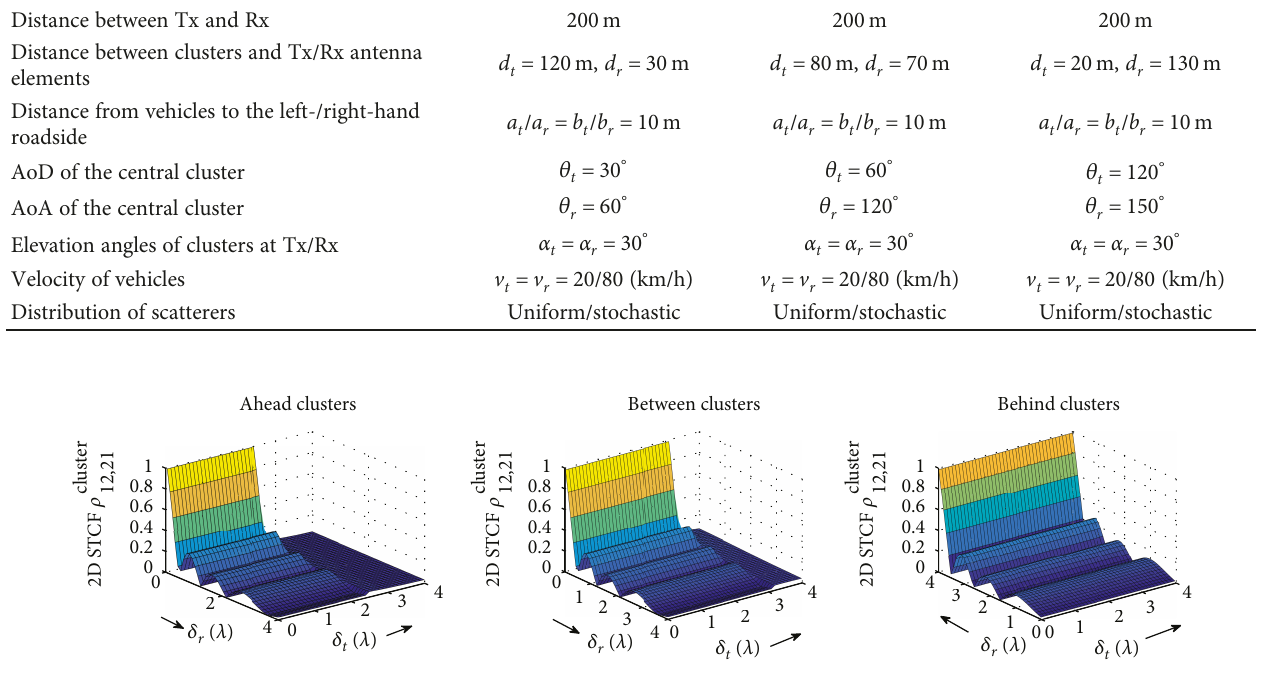
Figure 7: The absolute value of the 2D STCF ρ cluster